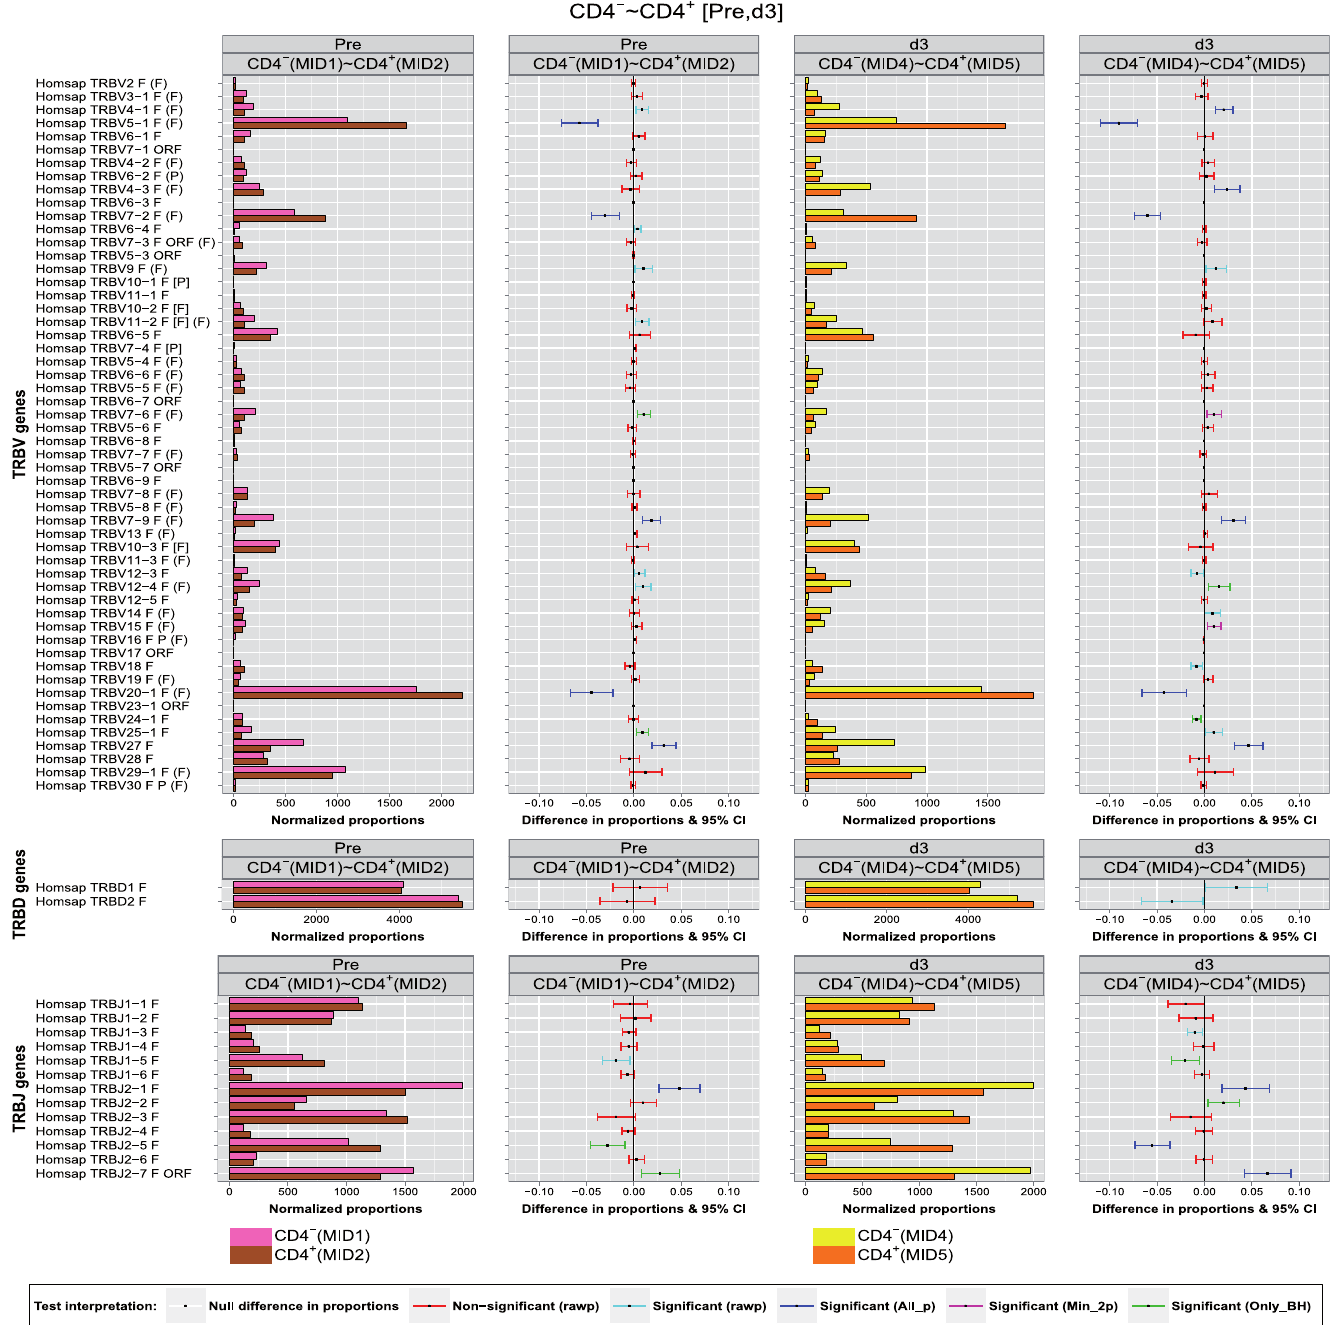
Fig 4. Synthesis graph (part 1: Pre, d3). The synthesis graph is displayed for Homo sapiens TRB IMGT clonotypes (AA) with a gene of a given group (TRBV, TRBD or TRBJ) between two T cell populations (CD4 - and CD4 + ) at two time points (Pre and d3), with for each time point, two panels. Left panel: normalized bar graph (IMGT clonotypes (AA) proportions normalized for 10,000 IMGT clonotypes (AA) per group), with juxtaposed colored bars corresponding to CD4 - (top) and CD4 + (bottom). Right panel: difference in proportions graph with significance and confidence interval (CI) bars. CI bar colors correspond to the test interpretation before adjustment of p -values (rawp) (non-significant: red, significant: light blue) and after adjustment by the multiple testing procedures (significant differences validated by the seven procedures (All_p): dark blue, by two or more multiple testing procedures (Min_2p): pink, and only by BH (Only_BH):